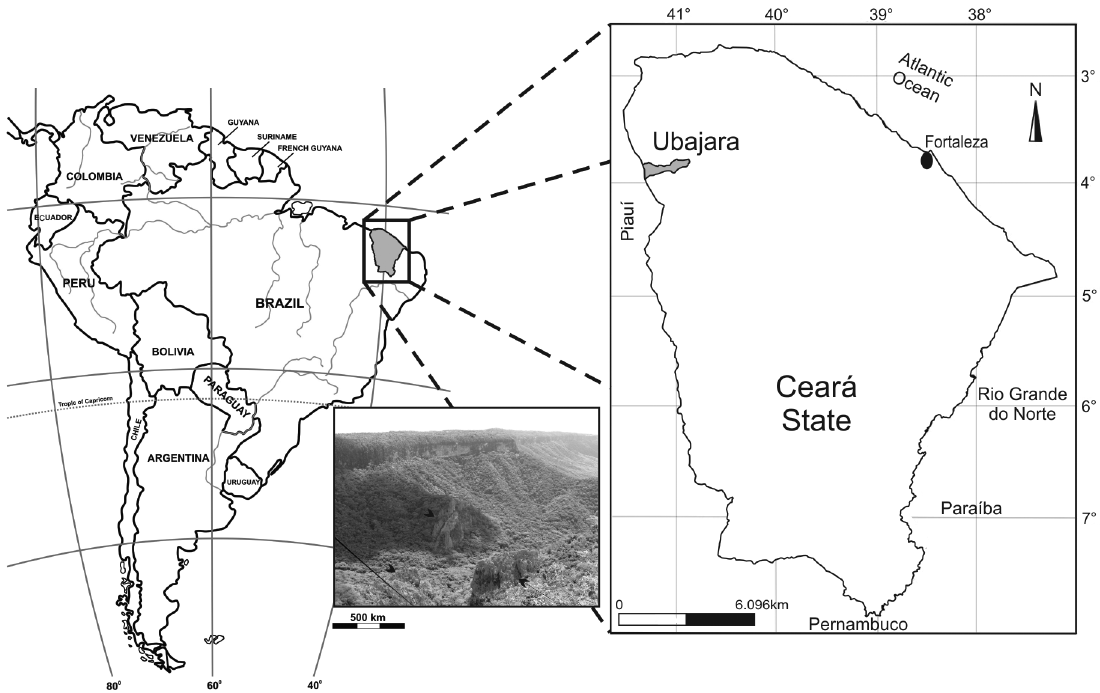
Figure 1 - Location map of the National Park of Ubajara, State of Ceará (above) and the limestone outcroppings (below) indicated by arrows. Modified from Oliveira et al.